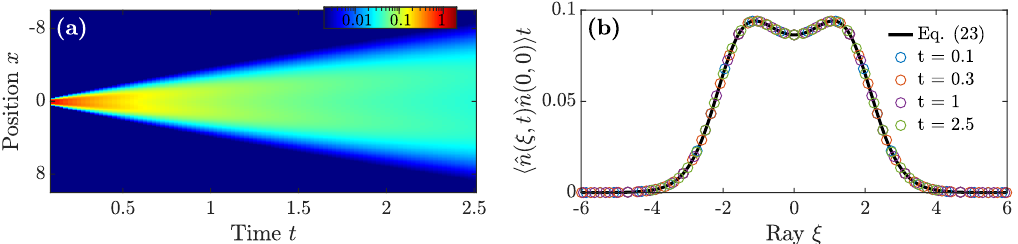
Figure 1: Two-point density correlation function of a homogeneous state in the Lieb- Liniger model. (a) Evolution of 〈 n ( x , t ) n ( 0,0 ) 〉 Eul evaluated via Eq. (18) and plotted using a logarithmic color axis. (b) Time-scaled correlations at selected times t plotted as circles against the ray ξ . The direct evaluation of Eq. (23) is plotted as a solid line and shows excellent agreement with the numerical implementation of the full formula from the homogeneous state. Simulation parameters can be found in the main